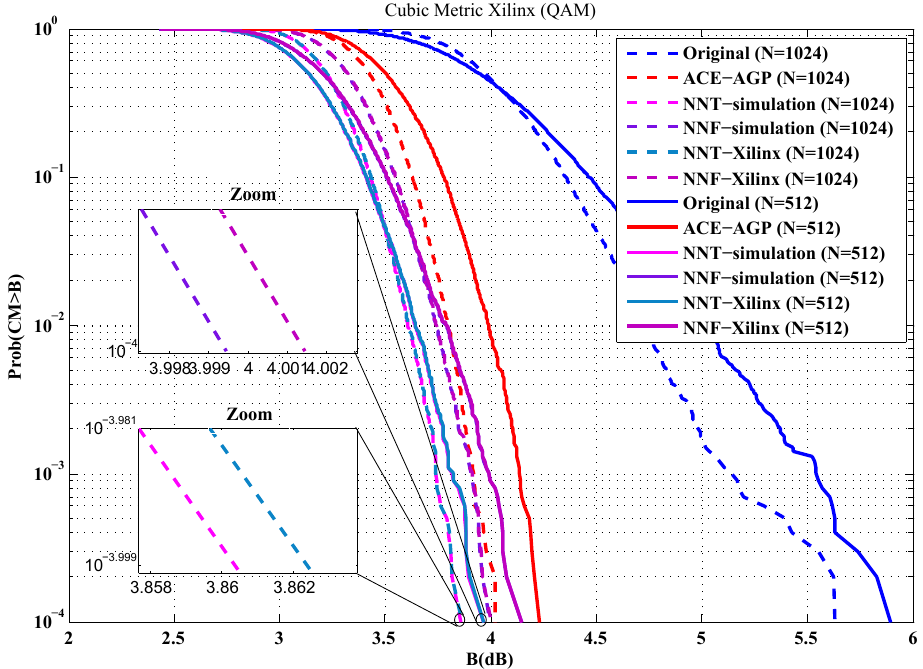
Figure 14. Cubic metric reduction in the case of 16-QAM modulation (Xilinx FPGA).